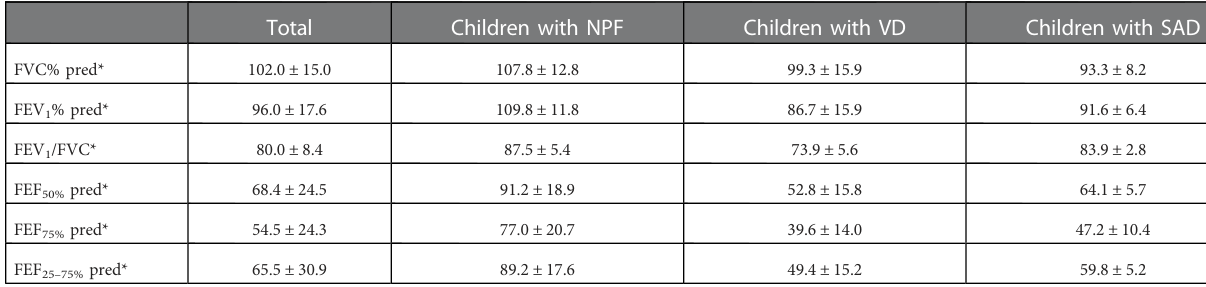
TABLE 2 Baseline spirometry parameters among the three pulmonary function